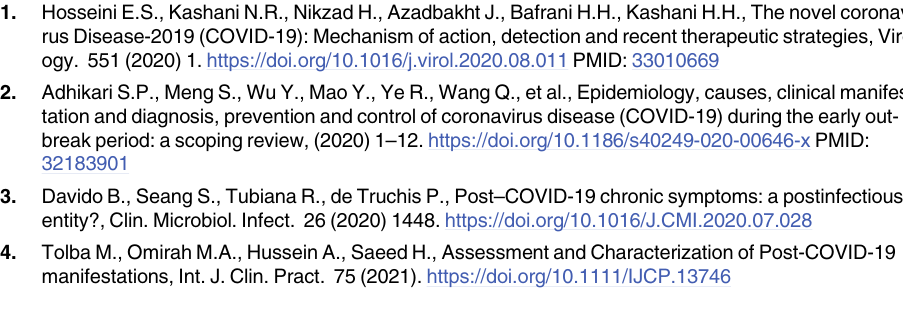
S1 Table. Univariate and multivariate analysis of associated